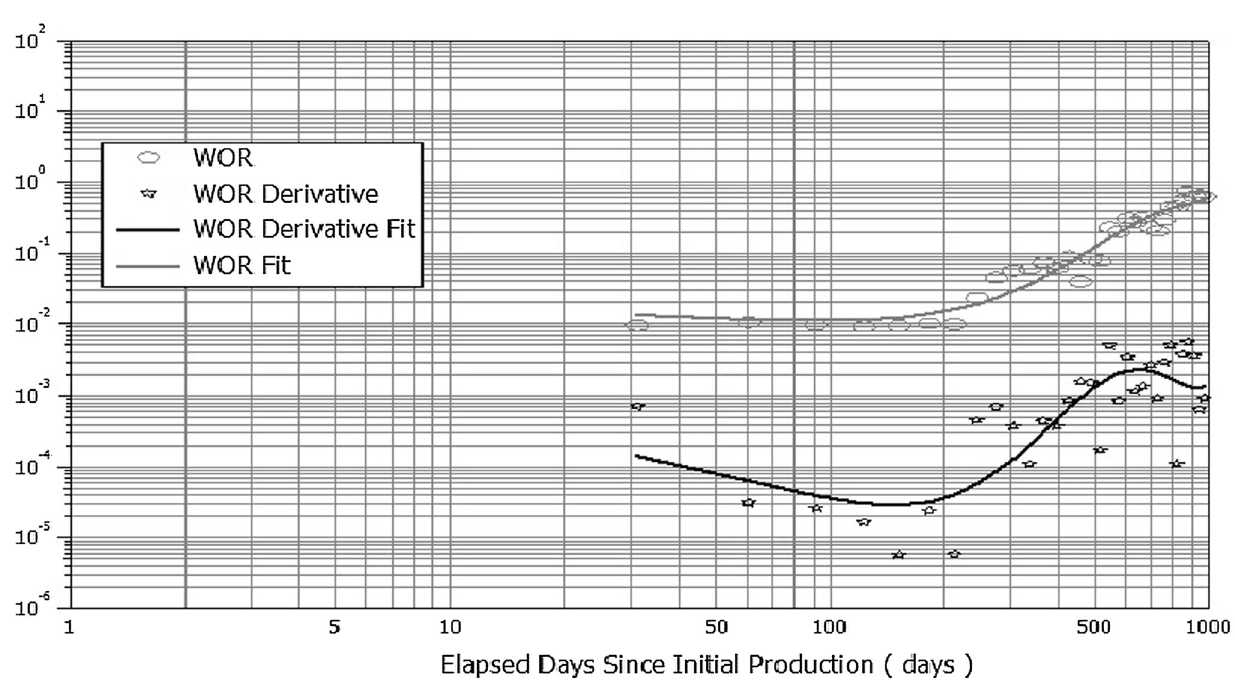
Fig. 3 Water control diagnostic plot of